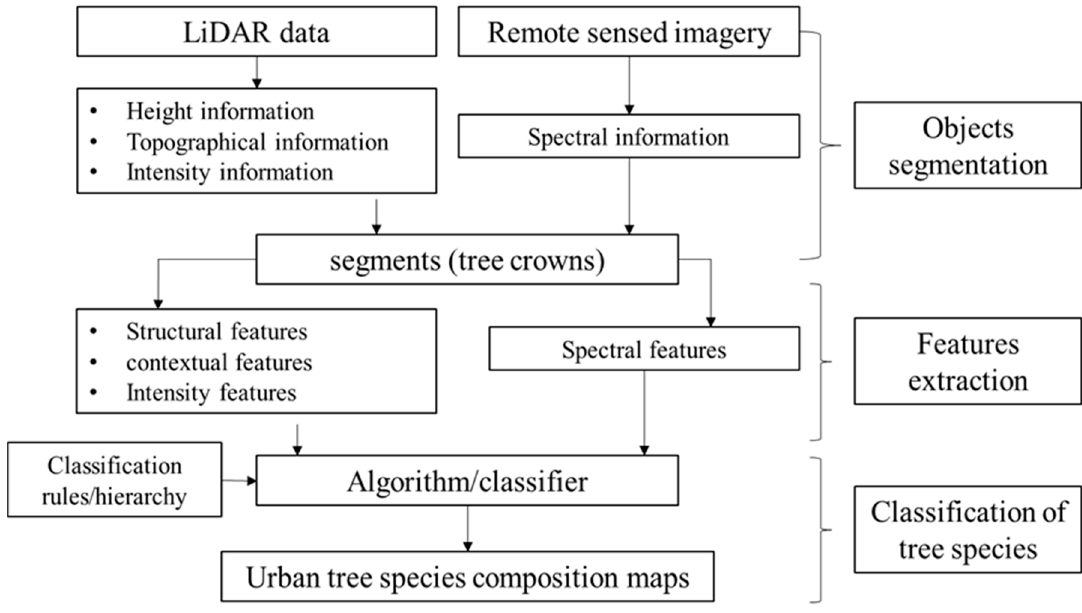
Figure 4. An illustration of the general urban tree species classification workflow.